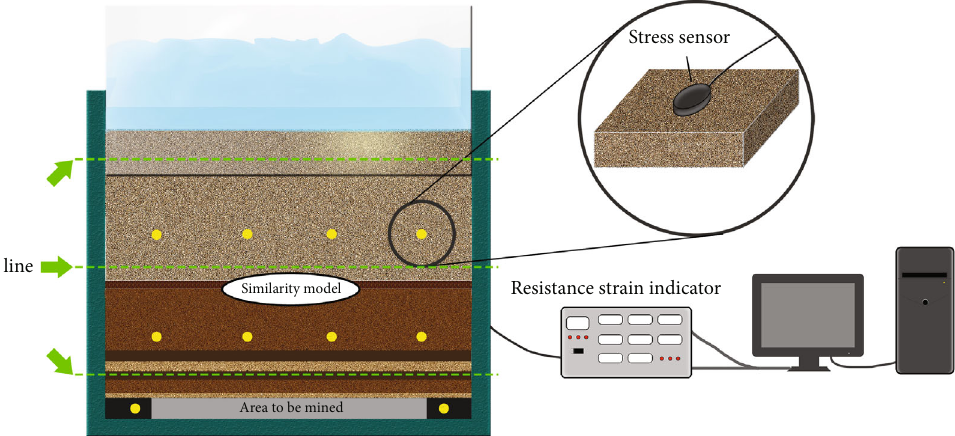
Figure 4: Two-dimensional “ hydromechanical ” coupling test system for surface water experiments.